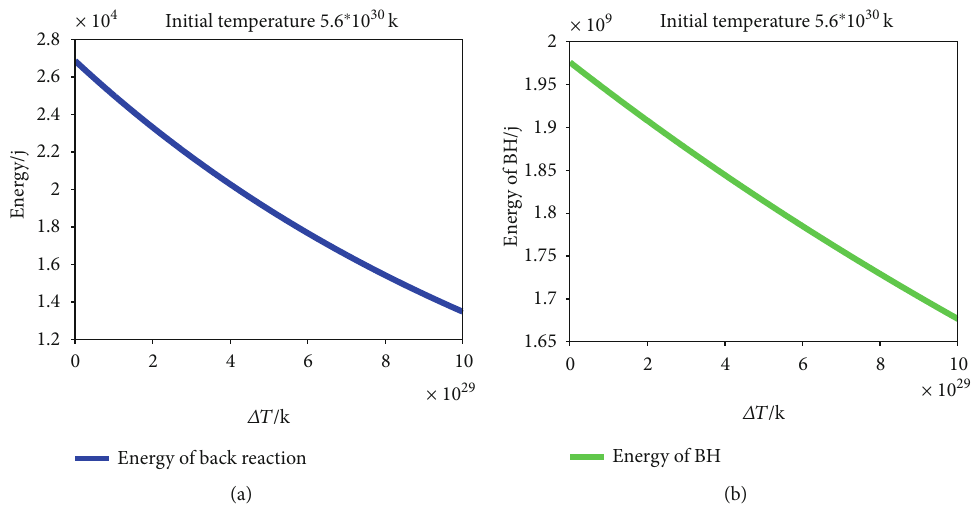
Figure 4: (a) shows the energy of membrane monotonically decreases as the temperature di ff erence increases. (b) shows the relationship between the energy of the black hole and the temperature di ff erence with an initial temperature 5 : 6 × 10 30